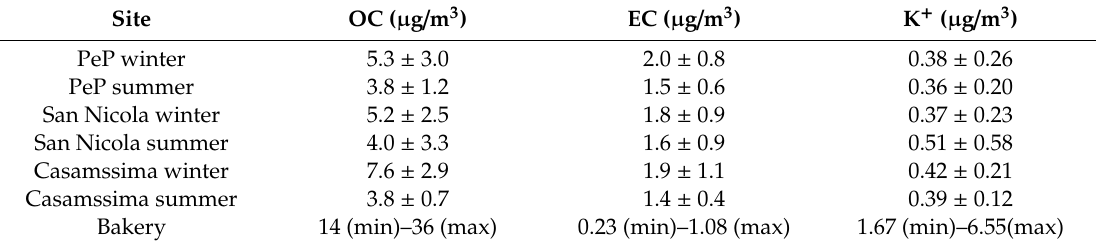
Table 3. OC, EC and K + mean values in outdoor PM 2.5 samples and indoor (bakery) PM 2.5 samples.